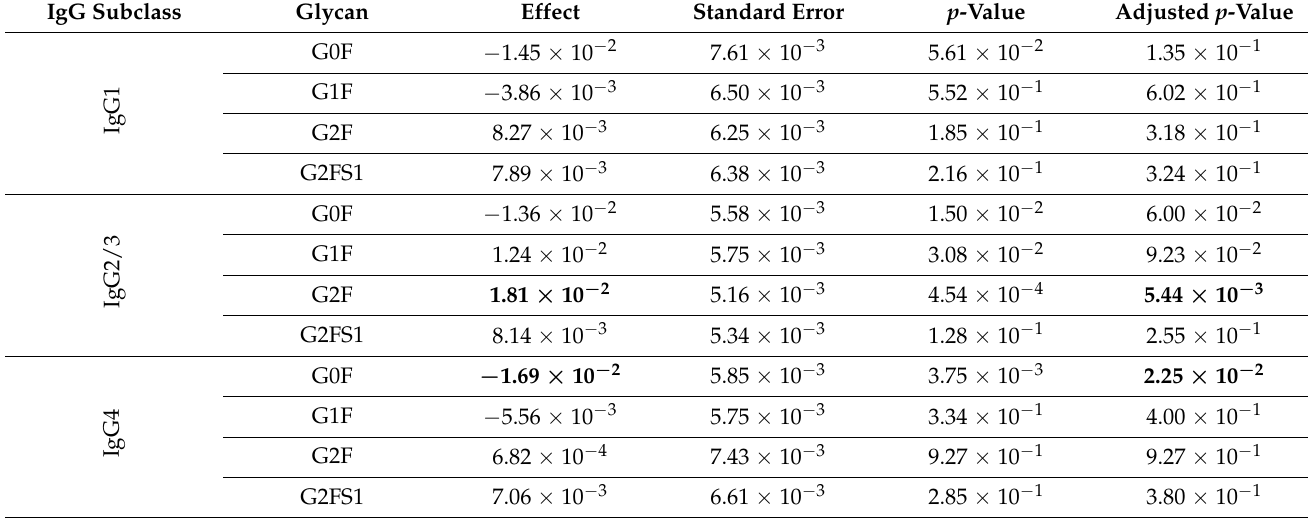
Table 2. Associations between the rate of change of IgG Fc glycan profiles and disease activity during UC and CD treatment—meta-analysis of three cohorts (Cohort 1–26 weeks, Cohort 2–30 weeks, and Cohort 3–14 weeks). Effect: the difference between two model coefficients (slopes), where each coefficient represents a group-specific weekly change of glycan trait (expressed in standard deviation units). p -values were adjusted for multiple testing and considered significant if <0.05 (bold). Changes in IgG glycan patterns with time on therapy in patients with active vs. inactive disease are visualized in Figures 3, S2 and S3, and results of statistical analysis for individual cohorts are shown in Table